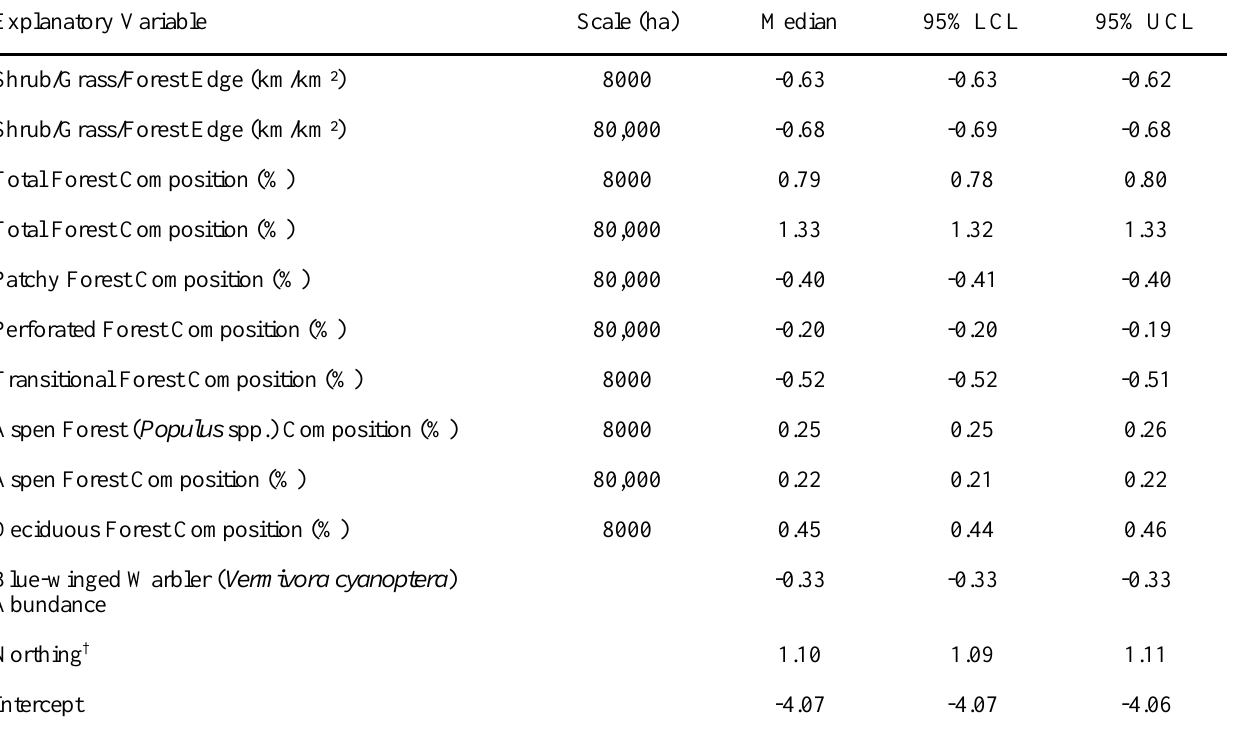
Table 3. Median and lower (LCL) and upper (UCL) confidence limits of the posterior distribution of explanatory variable slopes for an average model derived from the Kullback-Leibler best subset of models for the Golden-winged Warbler ( Vermivora chrysoptera ) in the Prairie Hardwood Transition of the upper midwestern United